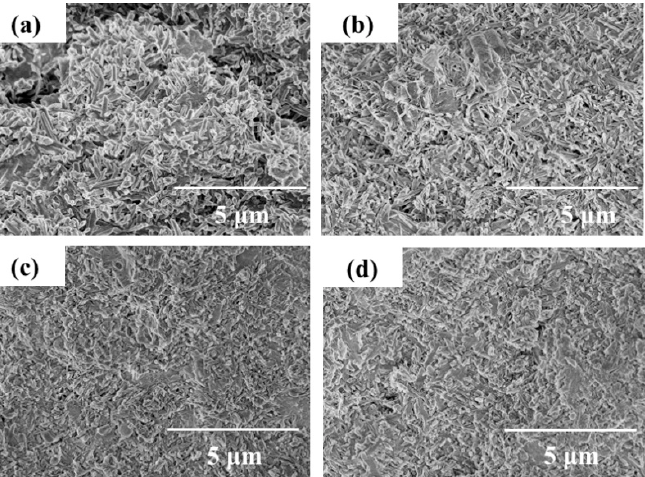
Figure 12. SEM topography of 28-dayMOC specimens at different temperatures and Baume degrees: ( a ) 600 °C, 24 Baume ( b ) 600 °C, 28 Baume ( c ) 800 °C, 24 Baume ( d ) 800 °C, 28 Baume.